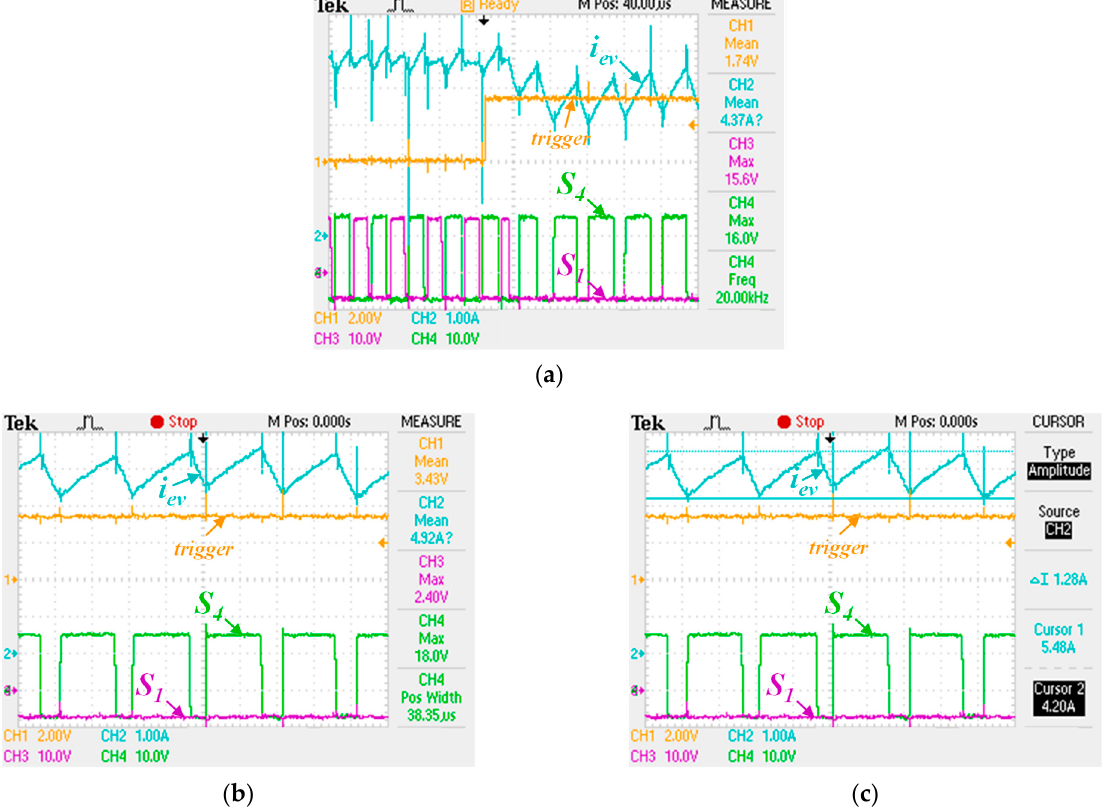
Figure 17. Transient-state operation of the multilevel dc–dc converter following a failure in the positive wire of the bipolar dc grid: ( a ) transition time from normal conditions (trigger value of 0 V) to fault conditions (trigger value of 3.3 V); ( b ) an i ev of 5 A and a duty cycle of 0% for semiconductor S 1 and 77% for semiconductor S 4 ; ( c ) an i ev ripple value of 1.28 A.